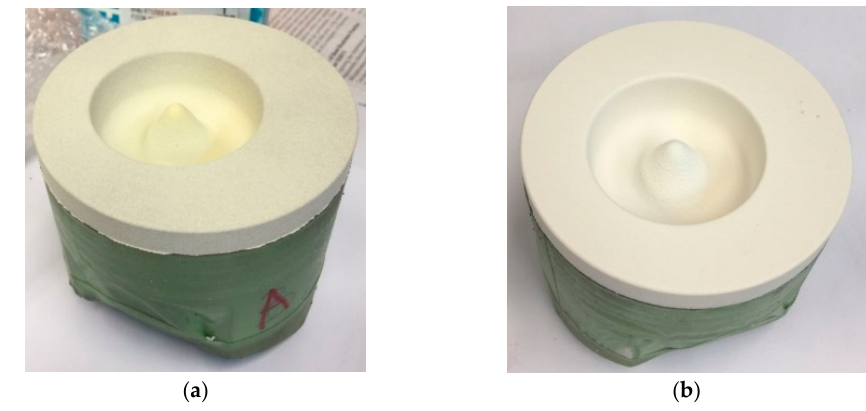
Figure 4. Piston coated with ( a ) YSZ and ( b ) Al 2 O 3 · SiO 2 .